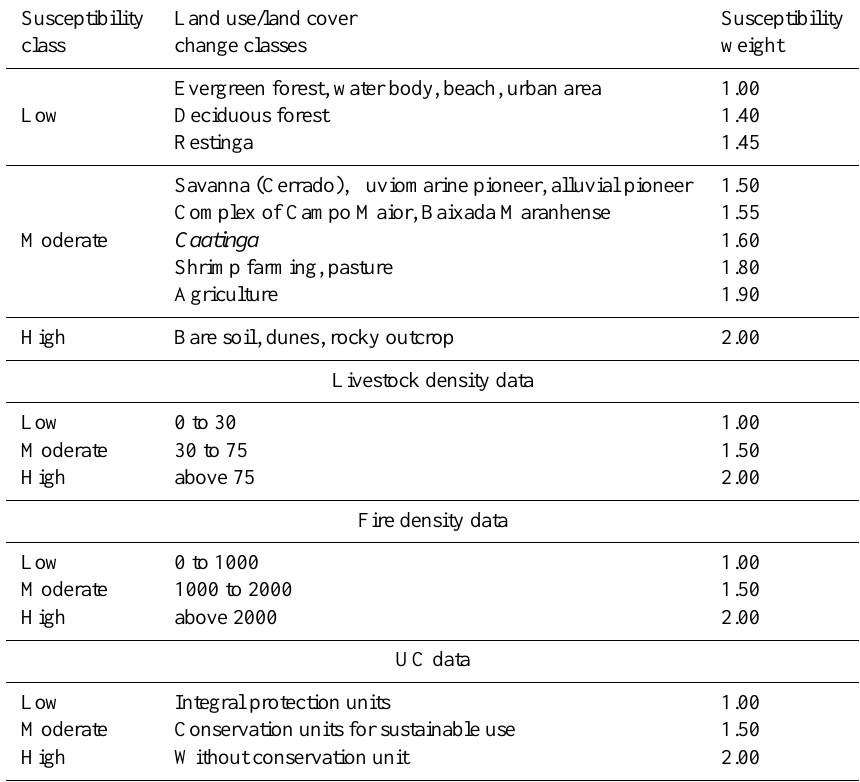
Table 4. Classes and weights of parameters used for management quality assessment.